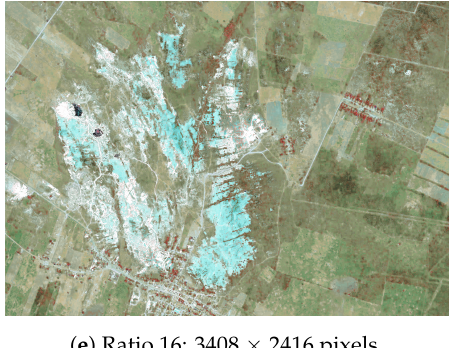
Figure 16. Generated spectral image compositions with different resolutions given the equivalent resized RGB image used as input in the trained neural network with 15 m pixel size images. Image differences between the generated and original individual bands are presented in Figure 17 showing minor differences, corroborated by Table 8 spectral quality indexes values. As before, following the Wald’s protocol, the generated images were resized to the pansharpened Landsat images